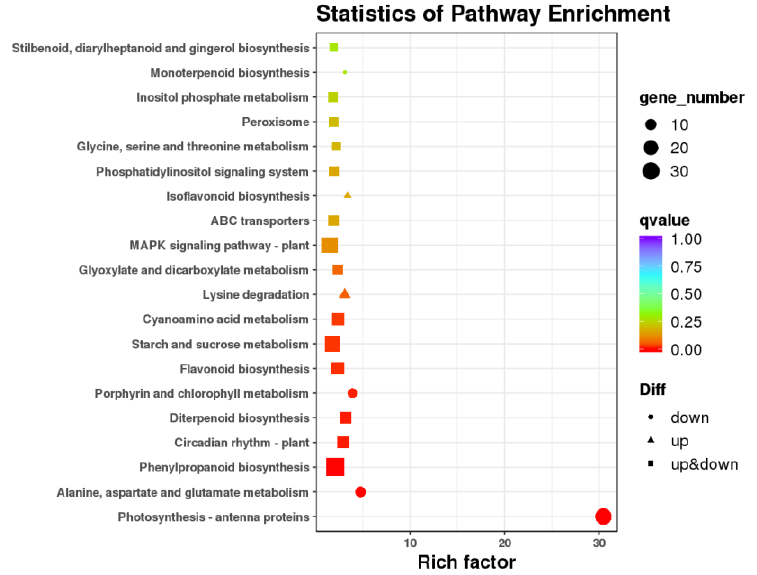
Figure 3. KEGG enrichment of DEGs. Note: The y -axis on the left represents KEGG pathways, and the x -axis indicates the “ Enrichment factor ” . Enrichment factor is calculated as “ Enrichment factor = (Ratio of DEGs annotated to the term over all DEGs)/(Ratio of genes annotated to the term over all genes) ” . A larger enrichment factor indicates a more significant enrichment of the pathway. The dots indicated the down-expressed DEGs were enriched in this pathway; the triangles indicated the up-expressed DEGs were enriched in this pathway; and the triangles indicated both the down- and up-expressed DEGs were enriched in this pathway. The color of the dots/triangles/squares stand for adjusted p value ( q value, FDR). The smaller the adjusted p value ( q value, FDR) is, the more signif- icant or reliable the enrichment is. The size of the dots/circles/squares represents the number of DEGs enriched in this pathway. The larger the dot is, the more genes it contains. KEGG: Kyoto Encyclopedia of Genes and Genome; DEGs: Differentially Expressed Genes. 3.4. Pigmentation Pathways Because the functional annotation revealed chlorophyll pathways, the gene expres- sion patterns of important chlorophyll metabolism genes were investigated further (Fig- ure 4). Almost all genes (nearly 83.33%) involved in chlorophyll biosynthesis (such as HE- MAs, GSAs, HEMBs, HEMCs, HEMHs, PPOX1s, GUN4s, CHLDs, CHLGs, CHLHs, CHLIs, CHLMs, CHLPs, CRD1s, DVRs, PORAs, and PORBs) showed decreased expres- sion in the SP group as compared to that in the CK group. Significantly, both HEMA1s and PORAs, the relative upstream and downstream genes in the chlorophyll biosynthesis pathways, respectively, were significantly downregulated. In the SP group, however, most genes (almost 74.07 percent) that positively regulate chlorophyll degradation, such as NYC1s, NOLs, HCARs, PPHs, PAOs, and RCCR1s, were marginally upregulated. For the genes involved in carotenoid biosynthesis (DXRs, GGPSs, PSYs, PDS1s, ZDS1s, CRTISOs, CYP97s, ZEPs, and NCEDs), 23 and 31 of them were up- and downreg- ulated in the SP group, respectively (Figure S5A). Furthermore, 28 and 34 of them affect anthocyanin biosynthesis (PALs, 4CLs, CHSs, CHIs, ANRs, UGT75L6s, 5MAT1s, and ANSs) were up and down-expressed genes in the SP group, respectively (Figure S5B).